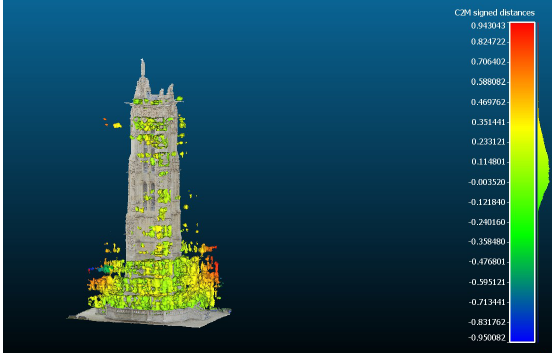
Figure 8 . Mesh-to-Mesh distance comparison between the mesh from the NeRF and from photogrammetry (chosen as